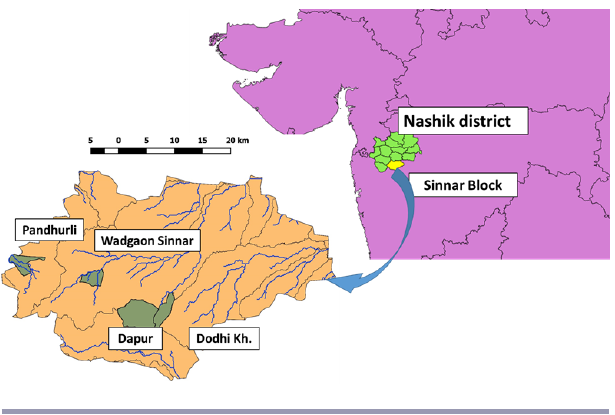
Fig. 1 . Field location: villages selected for field work in Sinnar block, Nashik district of Maharashtra state in western India.